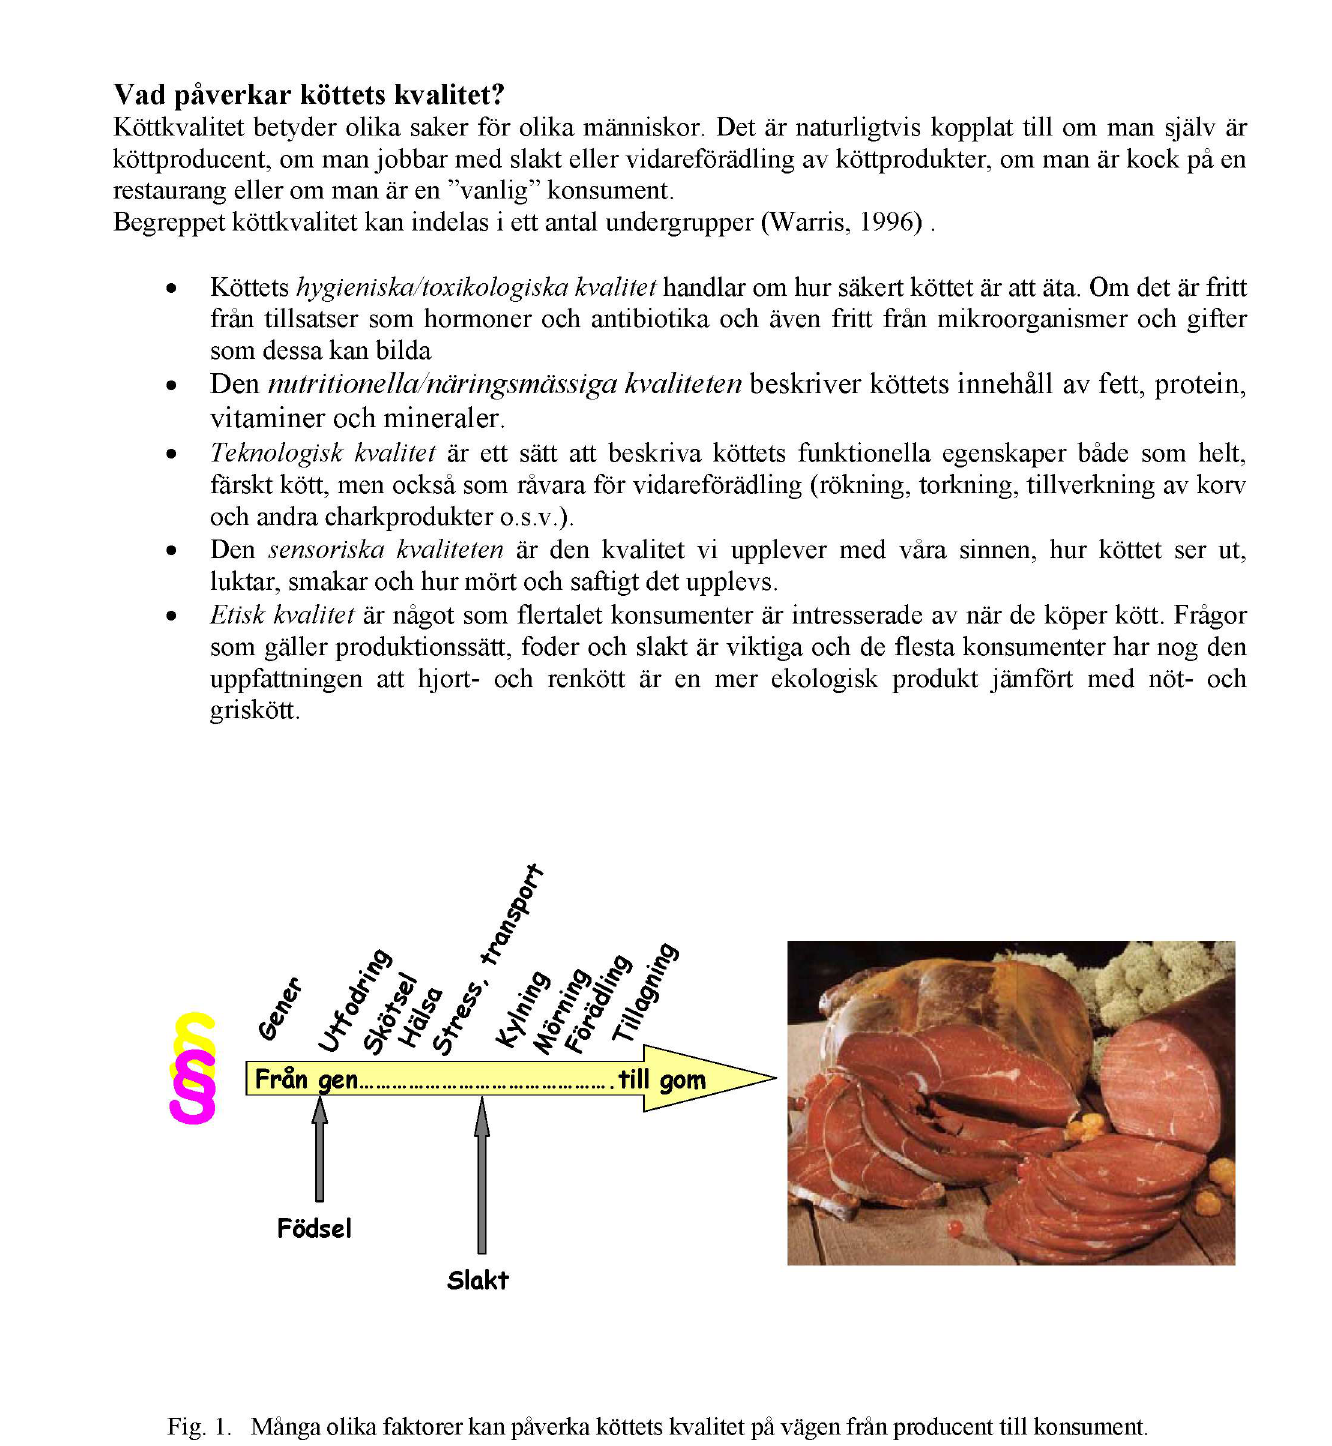
Fig. 1. Många olika faktorer kan påverka köttets kvalitet på vågen från producent till konsument. Redan före djurets födelse kan man genom avelsarbete påverka t.ex. hur mycket kött som kommer att ansåttas på slaktkroppen och hur kånsliga djuren år för stress innan slakt. Under